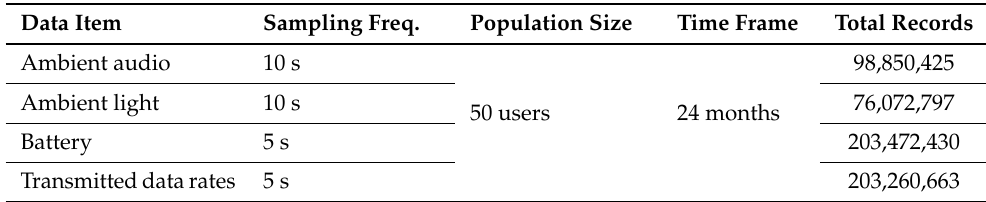
Table 2. Dataset